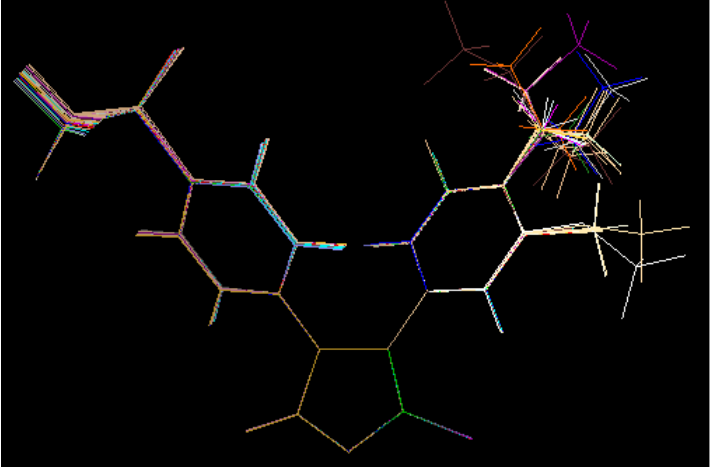
Figure 3. Superposition of 1,5-Diarylimidazoles accoriding to the optimized structures and alignment of the three cycle in